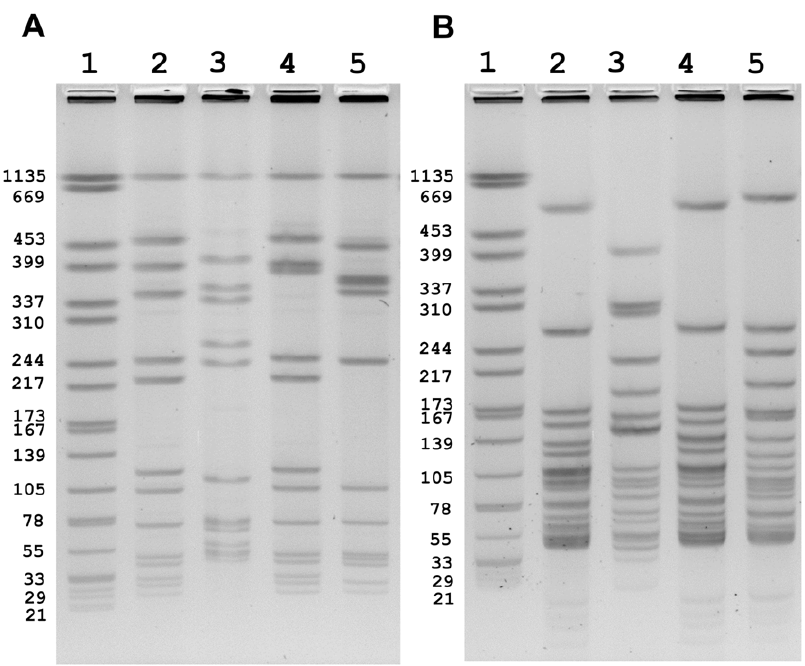
Figure 1. PFGE profiles ofListeriamonocytogenes cantaloupe outbreak strains. AscI patterns are shown in panel A: lane 2: GX6A16.0099 (III); lane 3: GX6A16.0019 (II); lane 4: GX6A16.0001 (IV); lane 5: GX6A16.0029 (I) and ApaI patterns in panel B lane 2: GX6A12.0001 (III); lane 3: GX6A12.0227 (II); lane 4: GX6A12.0001 (IV); lane 5: GX6A12.0069 (I). Lane 1 in both panels is Salmonella braenderup H9812 standard (digested by XbaI ). The Roman numerals represent the PFGE pattern combination.